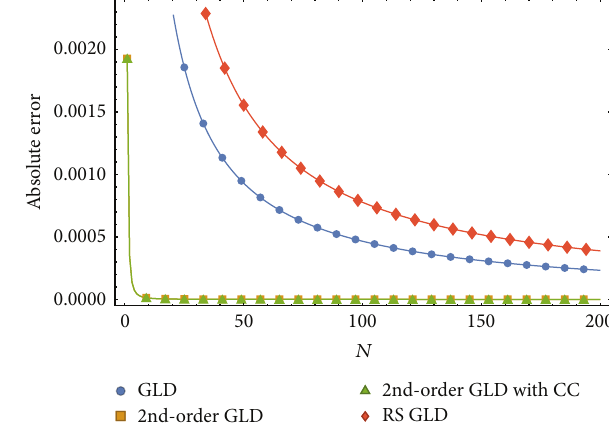
Figure 1: Absolute error over time domain for four different methods.